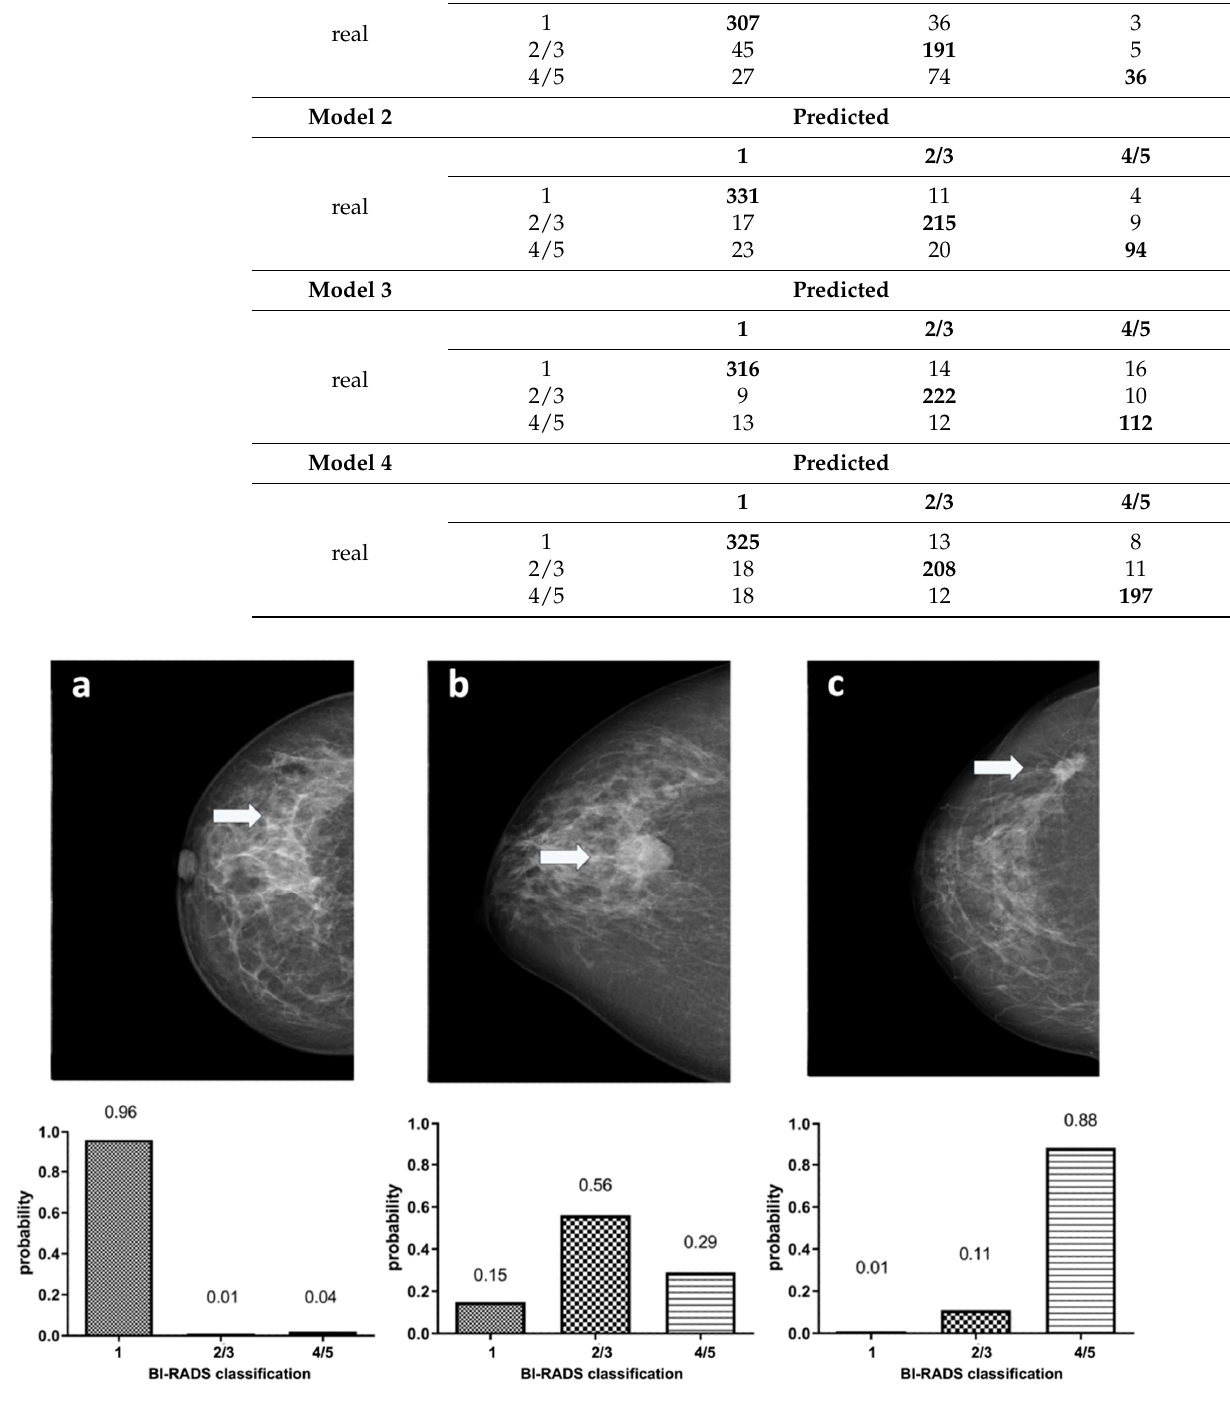
Figure 6. Example images showing (marked with an arrow) normal breast parenchyma ( a ), a probably benign soft tissue opacity ( b ) and a suspicious soft tissue opacity ( c ) with corresponding classification probabilities of dCNN model 3 to the three defined BI-RADS classes (1) “healthy tissue” (2/3) “probably benign soft tissue opacity” and (4/5) “suspicious soft tissue opacity”.